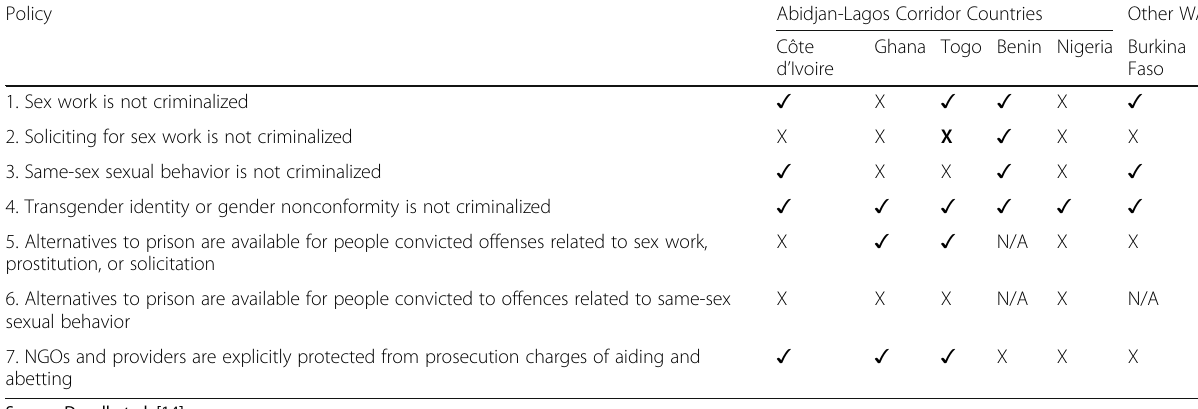
Table 1 Existence of criminalization laws and policies in Abidjan-Lagos Corridor Countries and Burkina Faso